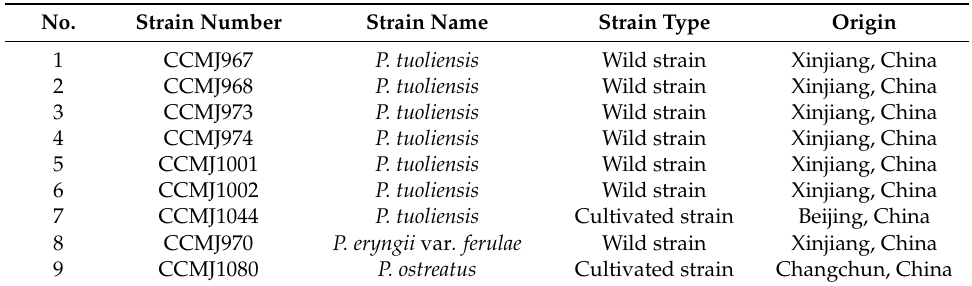
Table 2. Information about the nine Pleurotus strains used for isolating basidiospore-derived monokaryons in this